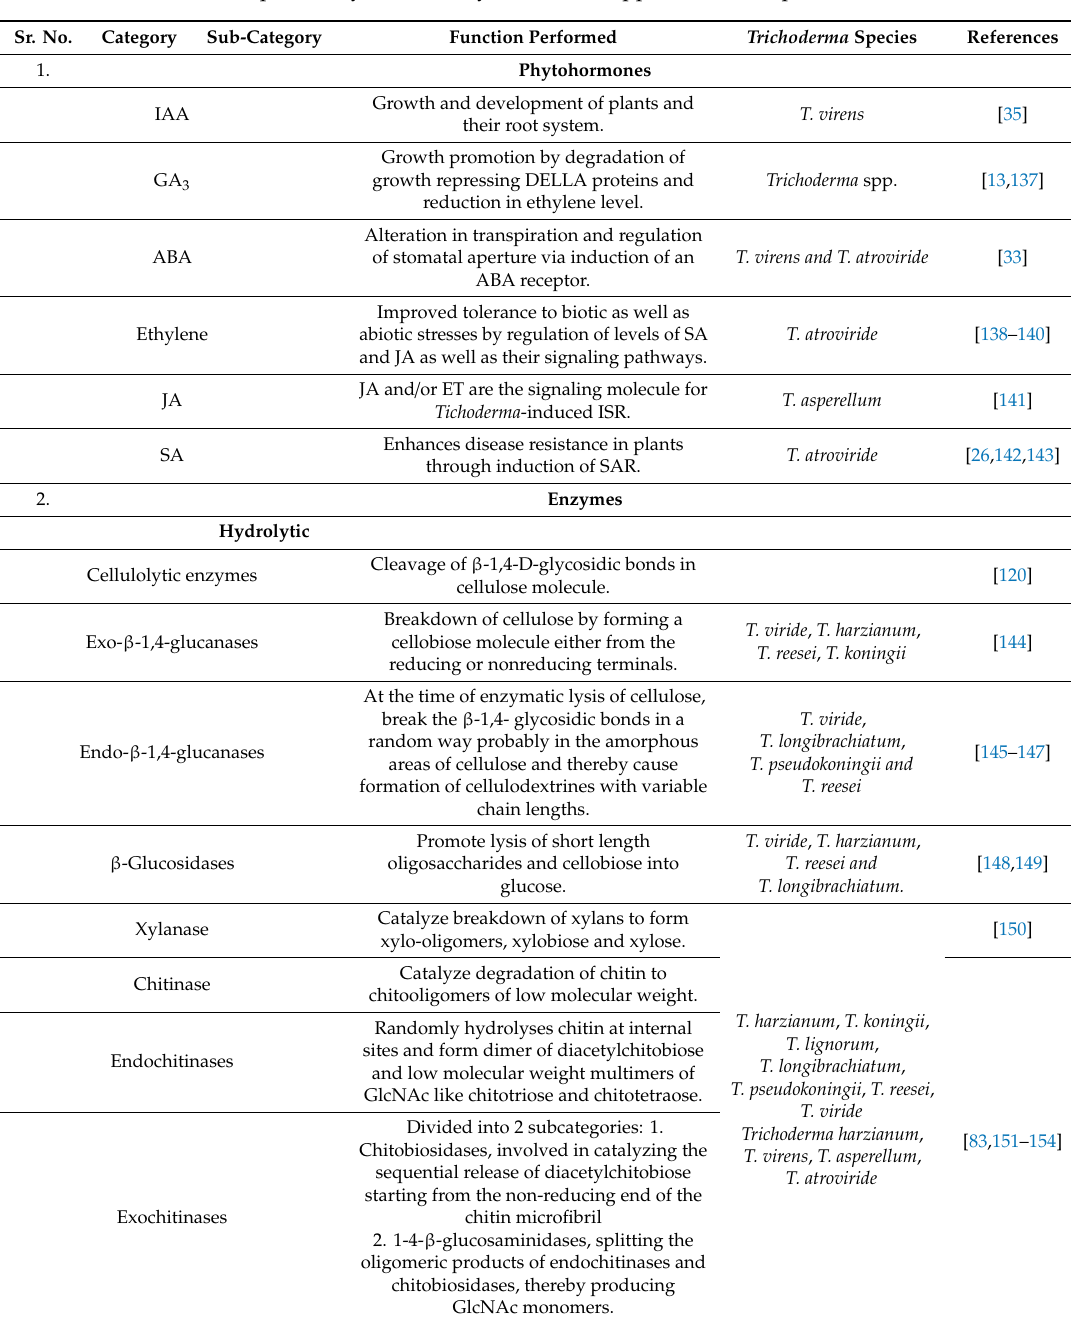
Table 1. Compounds synthesized by Trichoderma spp. involved in plant